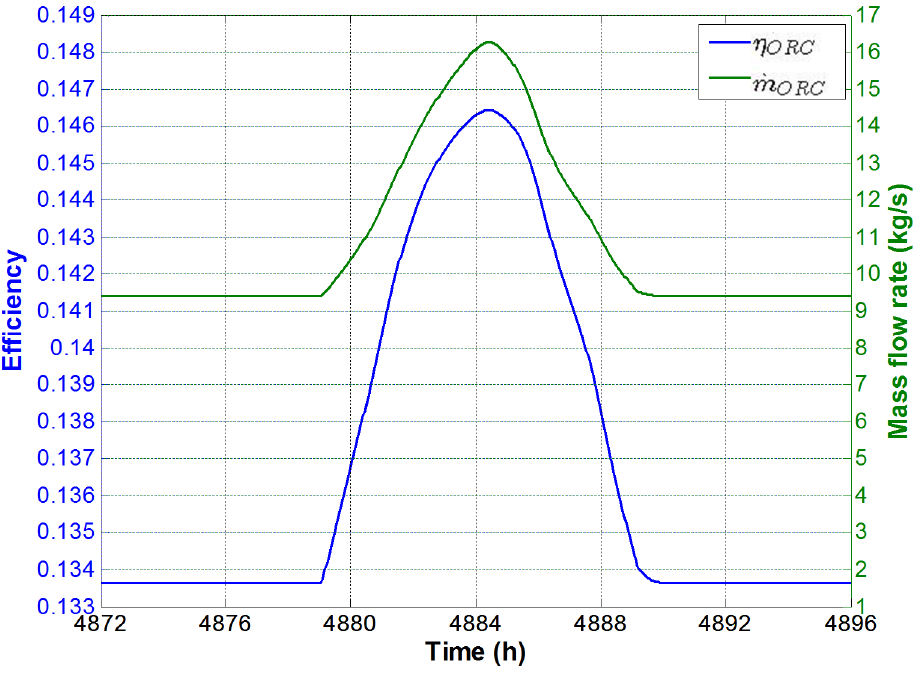
Figure 5. Efficiency and mass flow rates in a summer day.